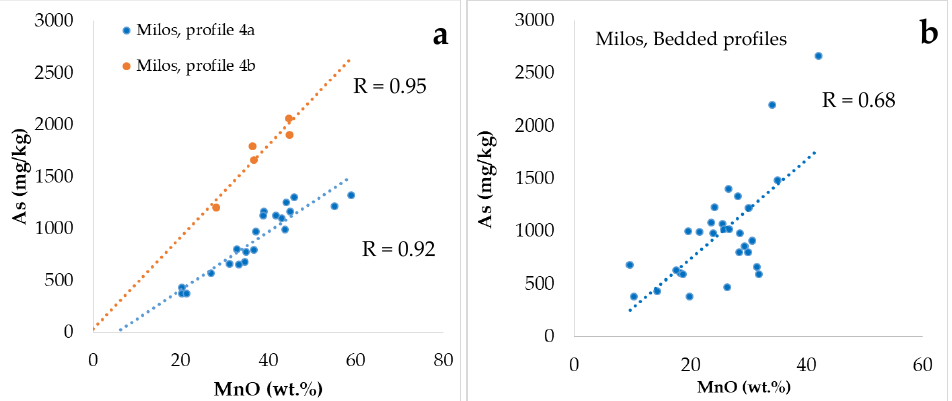
Figure 8. ( a , b ) Plots of As vs. MnO for Mn-Fe ores of the profile No 4a and 4b, both of “High-tem- perature hydrothermal Mn deposits” (Figure 5a) and “Bedded hydrothermal Mn deposits” (Figure 5b). Data from [10,11].